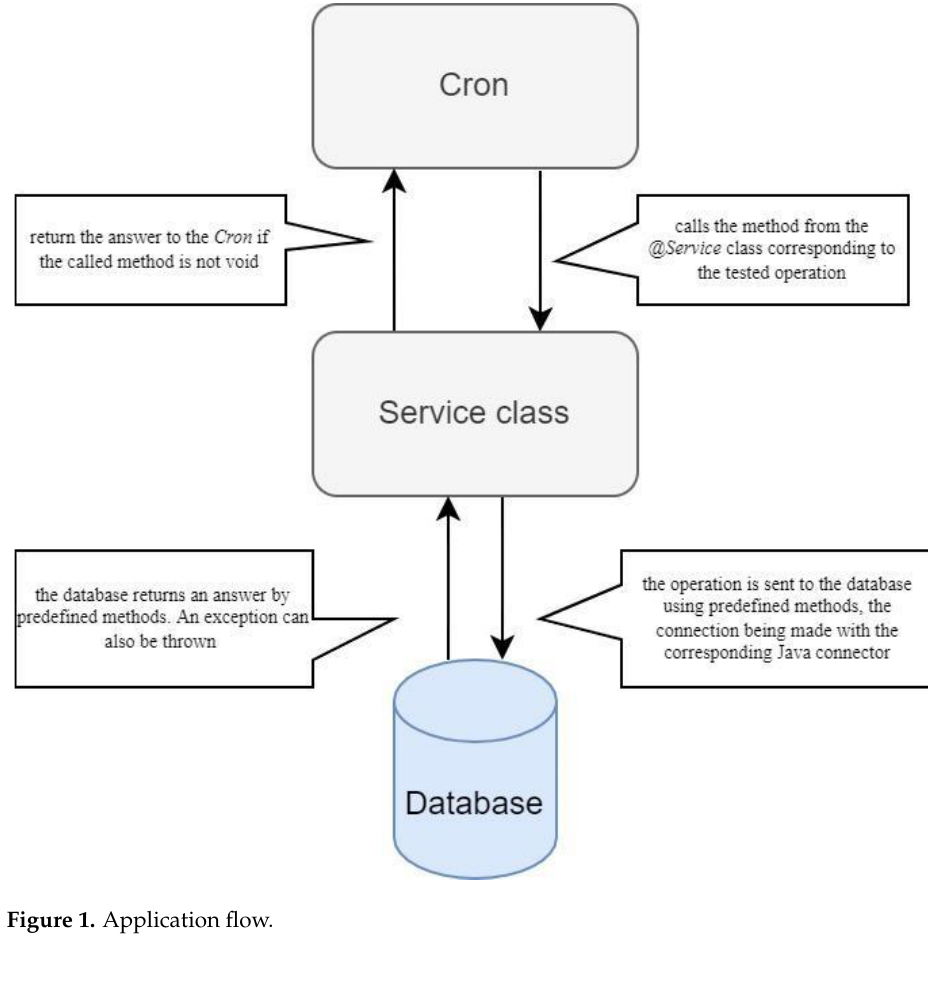
Figure 1. Application flow.